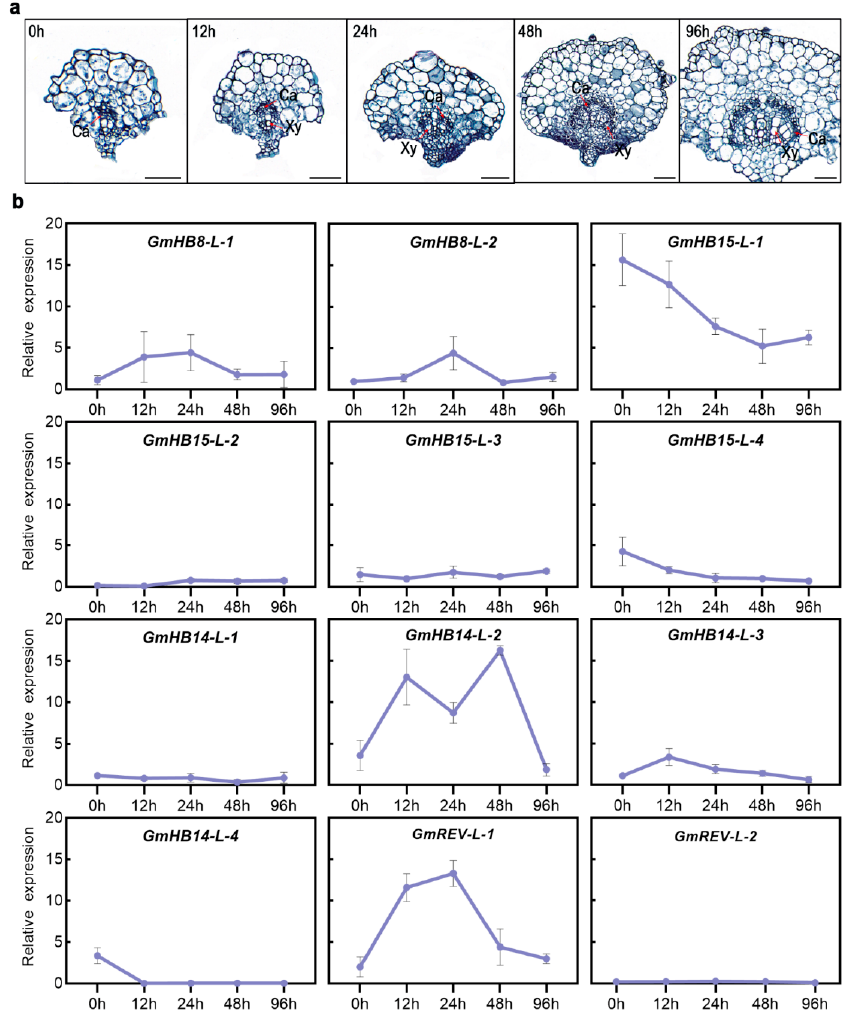
Figure 6. ( a ) Transverse sections of soybean leaf veins in five different developmental stages. All black scale bars indicate 100 μ m. ( b ) Expression profiles of 12 GmHD-Zip III genes in five stages of vein development. The normalized values of gene expression were log2-transformed and visualized in the form of